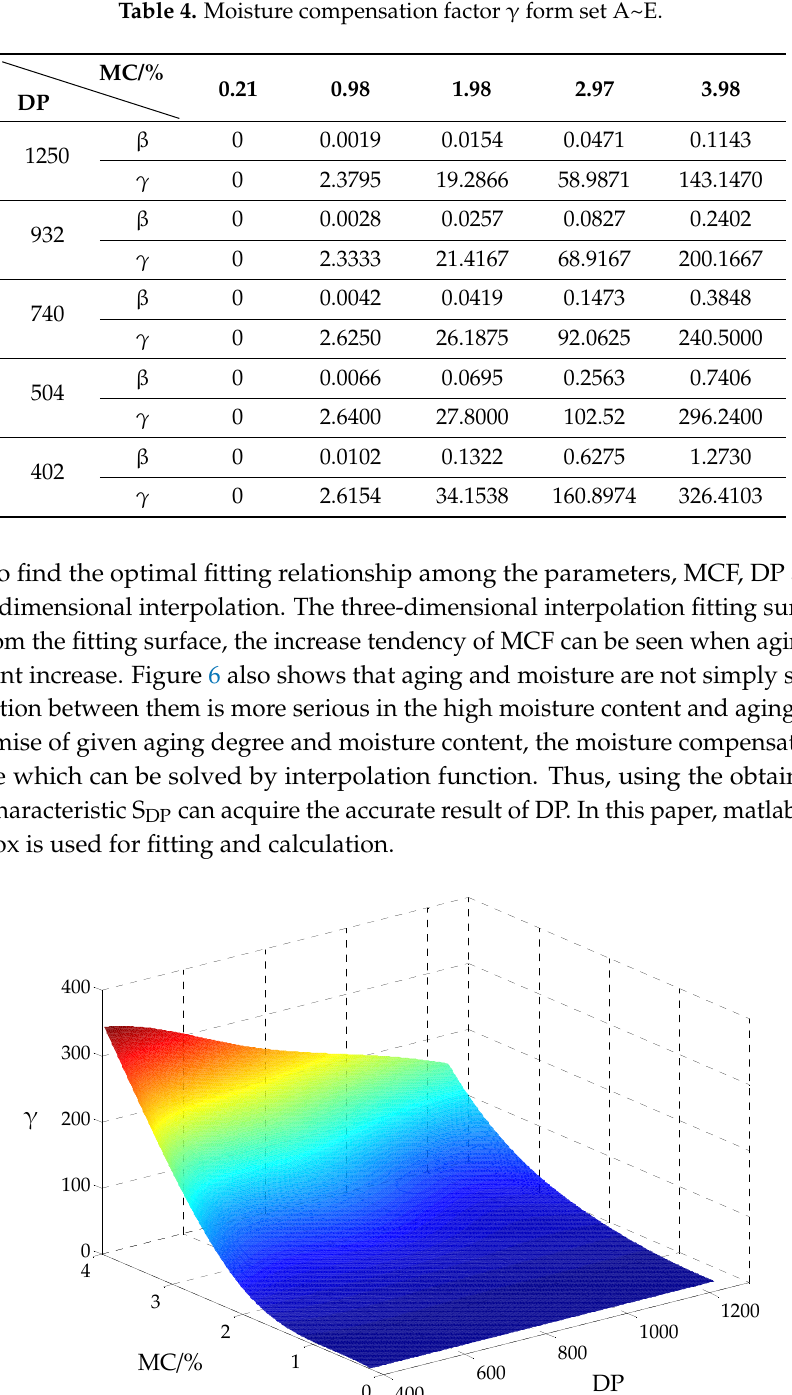
Table 4. Moisture compensation factor γ form set A~E.